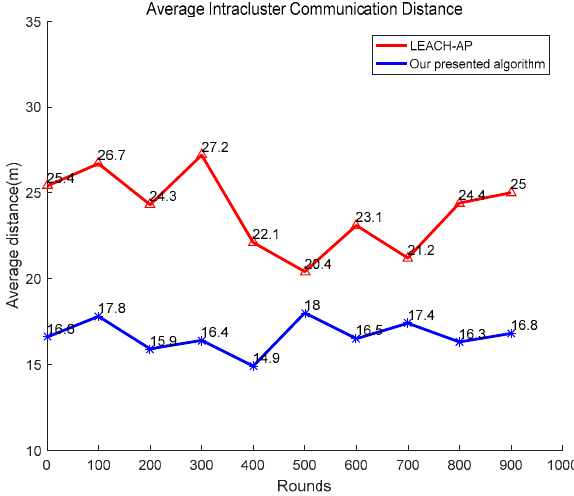
Figure 7. Comparison of average intracluster communication distance.